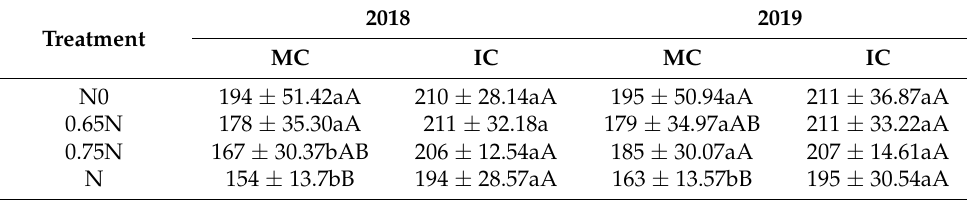
Table 7. Effects of different treatments on content of soil-available potassium (mg kg − 1 ).